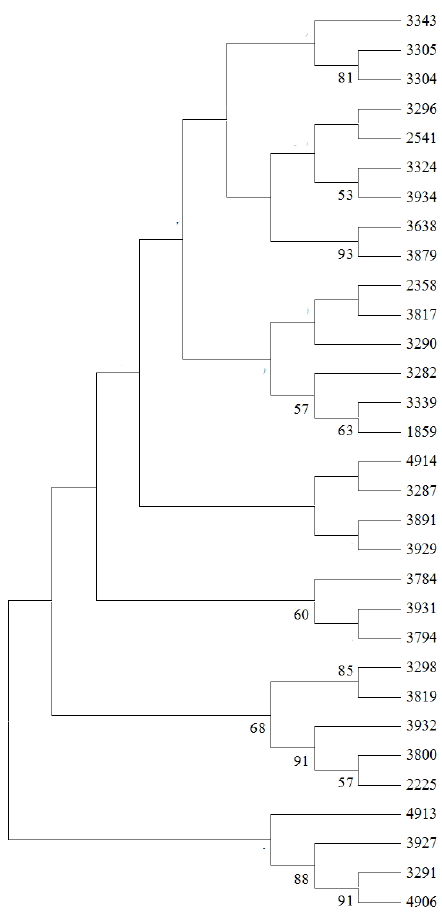
Figure 4. Phylogenetic tree of 31 sesame accessions derived from NJ analysis based on 218 SSR markers. Bootstrap values >50 are